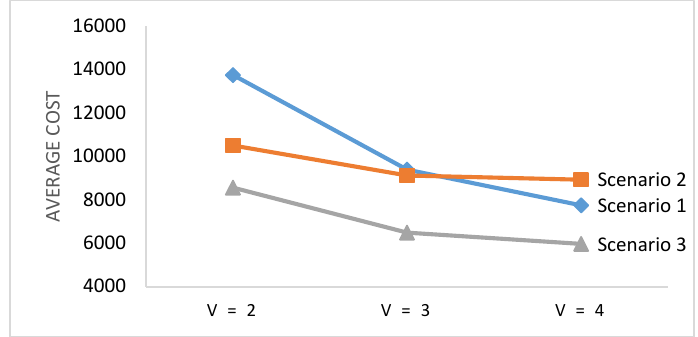
Fig. 9. Effect of 𝑉 on the optimal total cost values for 𝑇 = 6 (MILP-C model)